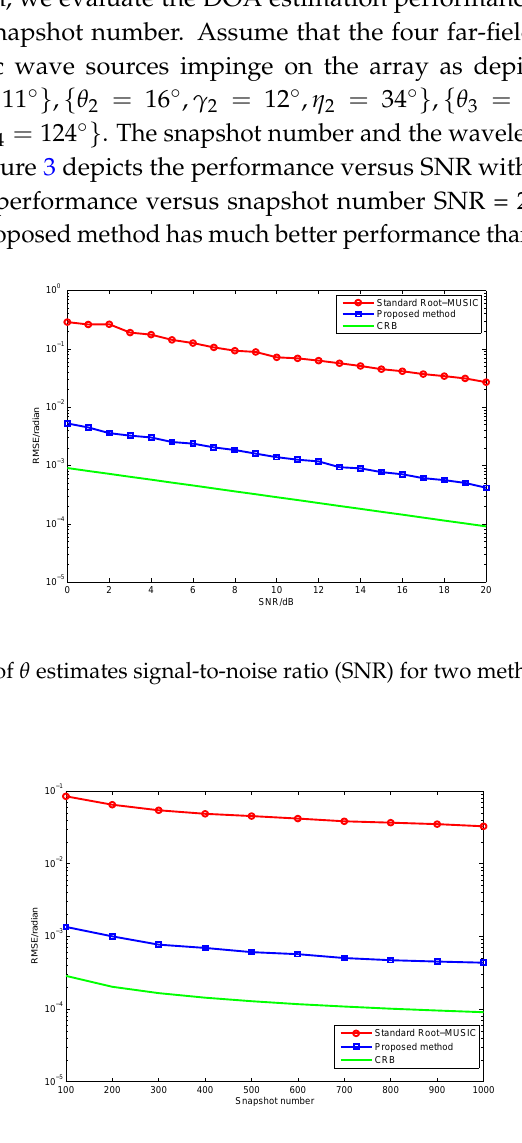
Figure 4. RMSE versus θ estimates snapshot number for two methods with fixed SNR of 20